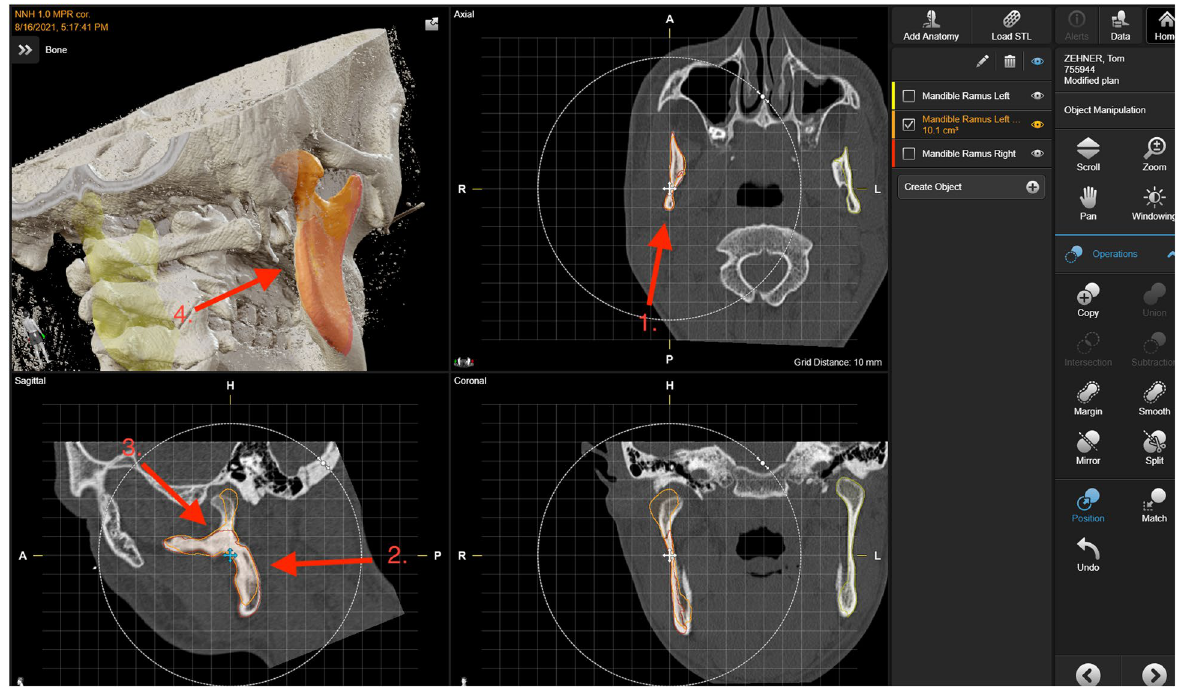
Fig. 1 The non-fractured ramus (yellow) is mirrored (orange), afterwards the read edge (1., 2., 4.) and the incisura (3.) must correspond as much as possible. The result is visible at the up left picture, showing a good correspondence and the fracture line on the edge between the mirrored ramus (orange) and the fractured ramus (red). Program used is BrainLab ® from Brainlab AG, Munich,